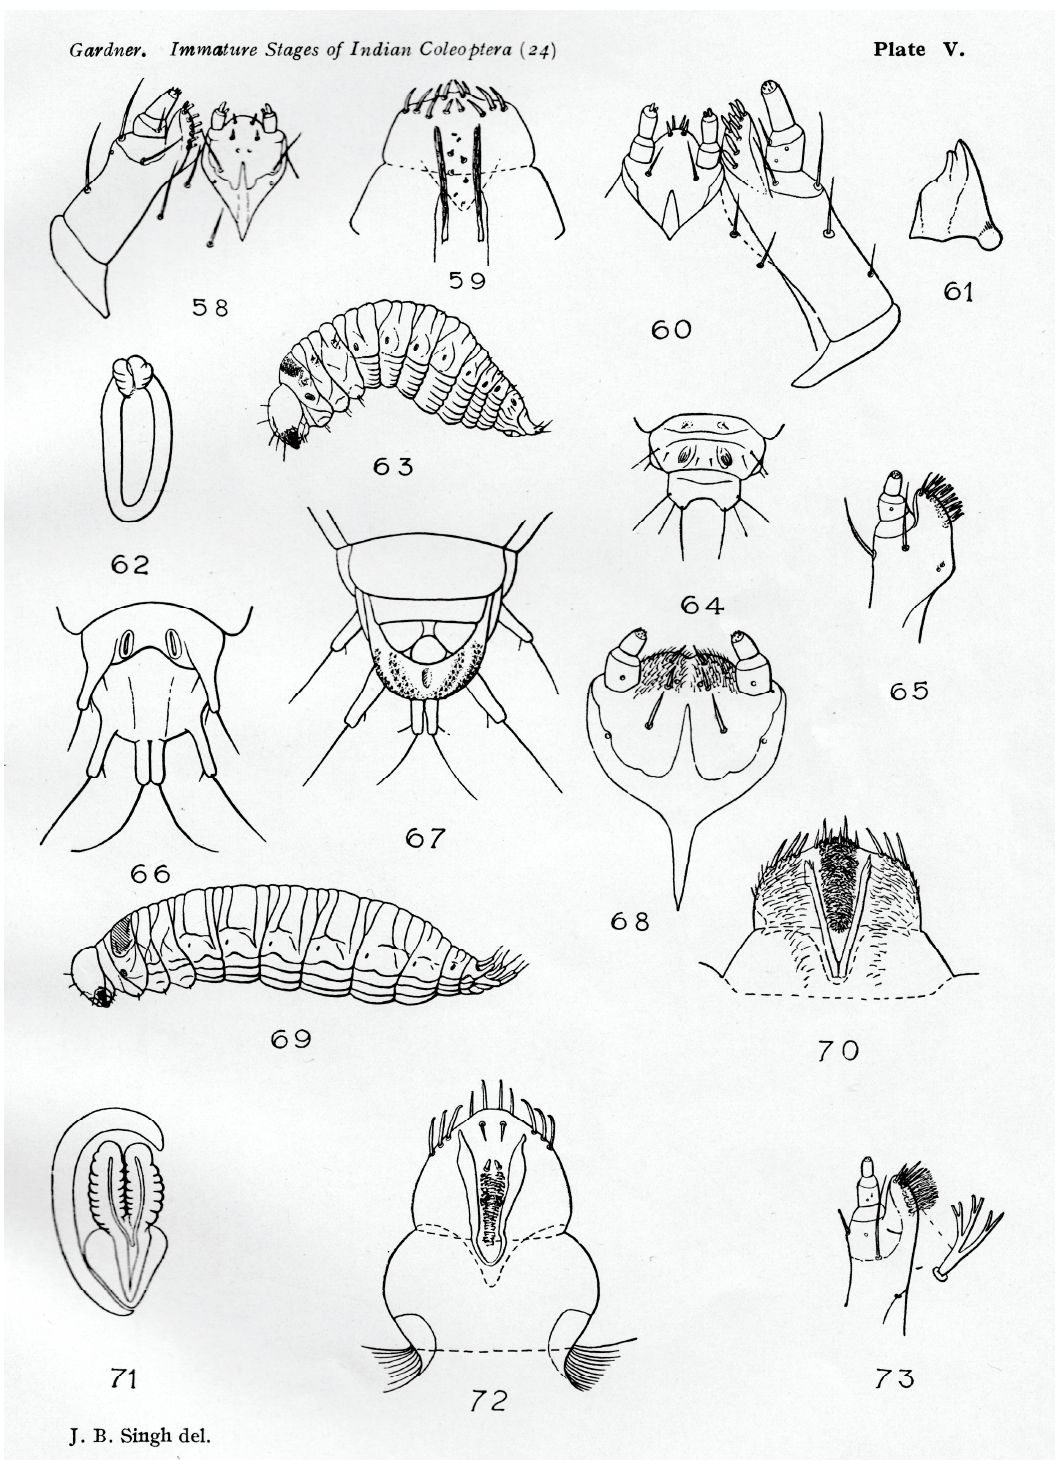
Figure 61. Reproduction of Gardner’s ([12], p. 260) Plate V: “Larvae of Curculionidae. Figure 58. Himatinum lalli , ventral mouthparts. Figures 59 and 60. Phloeophagosoma aesculi . 59. Epipharynx. 60. Ventral mouthparts. Figures 61 and 62. Macrorhyncholus ventilaginis . 61. Mandible. 62. Spiracle. Figures 63 and 64. Trochorrhopalus [sic] balwanti . 63. Larva. 64. Caudal extremity, dorsal view. Figures 65–71. Anius [ Nephius ] pauperatus . 65. Maxillary mala and palp. 66. Caudal extremity, dorsal view. 67. Caudal extremity, ventral view. 68. Labium. 69. Larva. 70. Epipharynx. 71. Spiracle. Figures 72 and 73. Dryophthoroides parvungulis . 72. Epipharynx. 73. Maxillary mala and palp.”